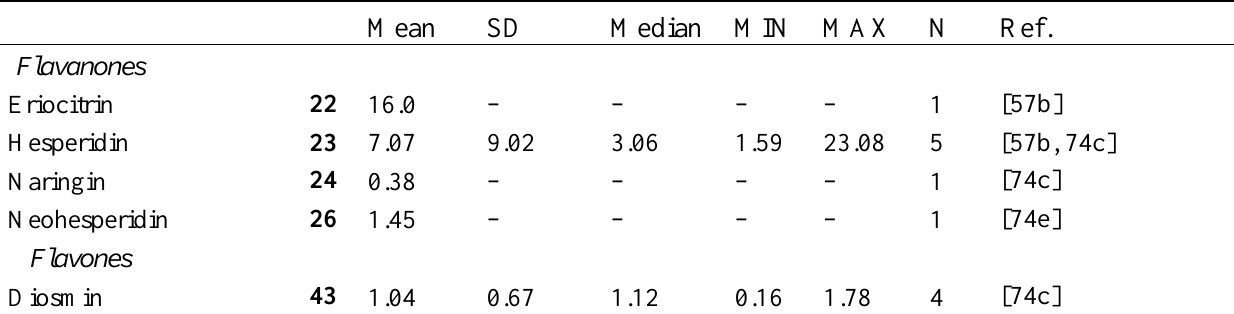
Table 13 . Flavonoid composition of commercial lemon juice (mg/100